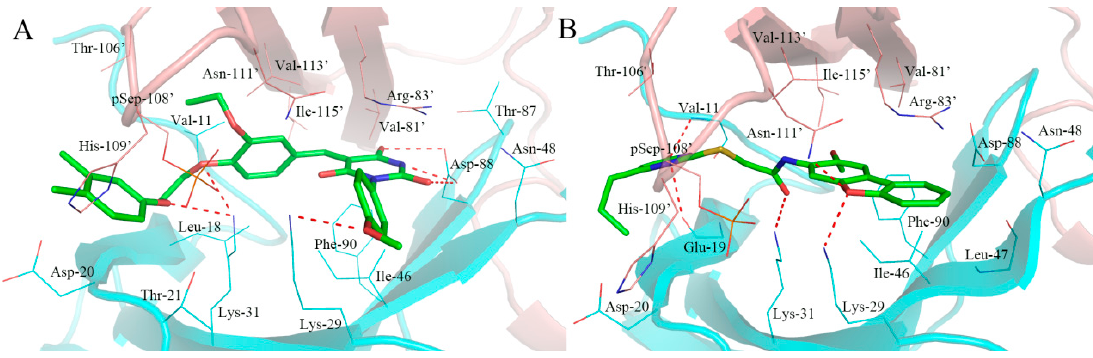
Figure 8. The binding modes of typical activators for α 2 β 1 γ 1 AMPK isoform. ( A ): M2958-7438; ( B ): M5050-0116. The α subunit was shown in the illustration and colored cyan and the β subunit was shown in the illustration and colored pink. The hydrogen bonds were labeled with red dashed lines.